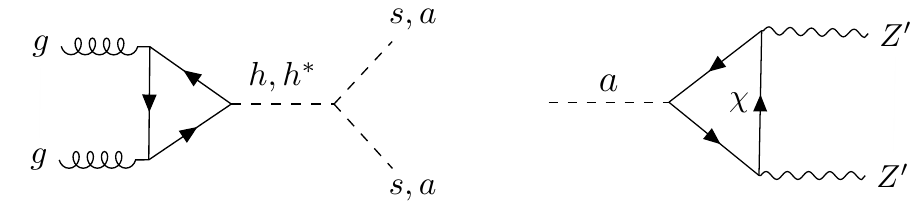
Figure 9. Main production channel (left) and decay channel (right) for the light singlet scalar a